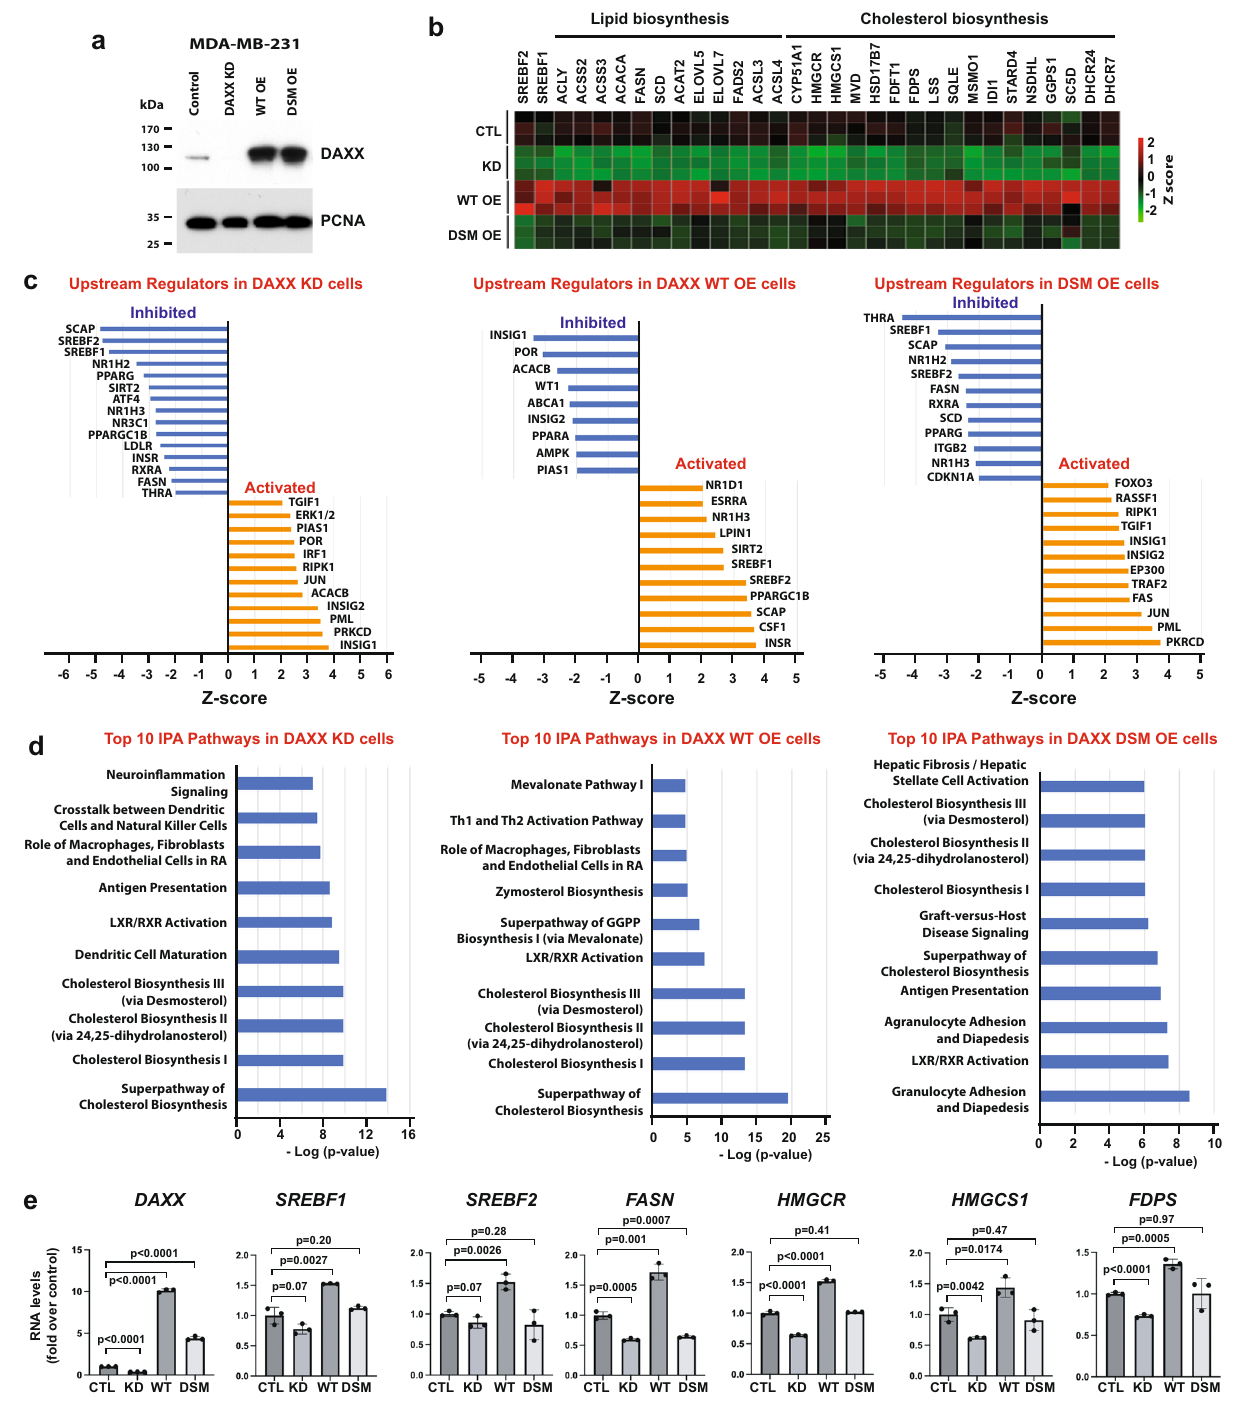
Fig. 1 | DAXX promotes lipogenic gene expression and its SUMO-binding property is required. a Validation of shRNA-mediated DAXX knockdown (KD)and the overexpression of wild-type DAXX (WT OE) and the SUMO-binding defective mutant ( DSM OE) compared to cells with a control vector (CTL) in MDA-MB-231 cells by immunoblotting. b An expression heatmap of selected genes in the lipo- genesispathwayinMDA-MB-231-derivedcells(CTL,KD,wtOE,andDSMOE)based on microarray data (triplicates for each group). c, d Ingenuity pathway analysis (IPA) for upstream regulators ( c ) and canonical pathways ( d ) using differentially